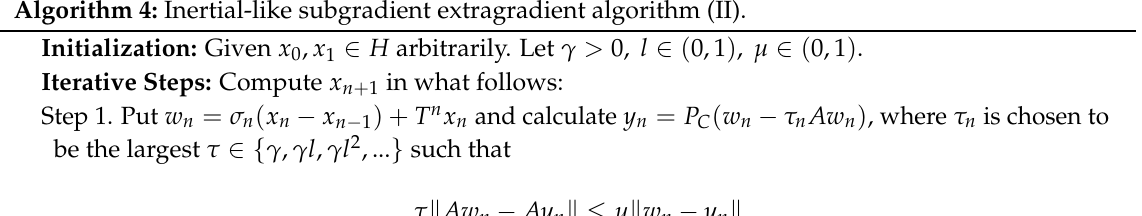
Algorithm 4: Inertial-like subgradient extragradient algorithm